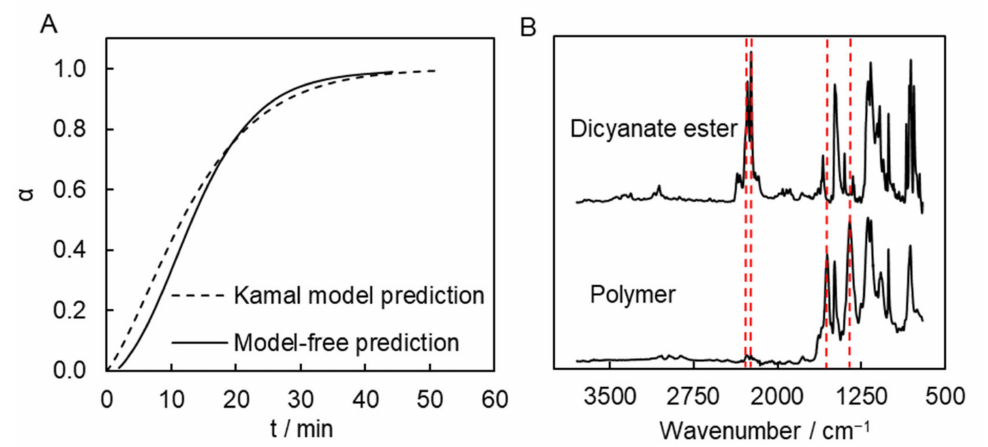
Figure 6. Predicted conversion-time curves for polymerization at 300 ◦ C ( A ) and FTIR spectra of dicyanate ester and its polymerization product ( B ). Dashed lines represent absorption peaks at 2269, 2237, 1550, and 1350 cm − 1 .